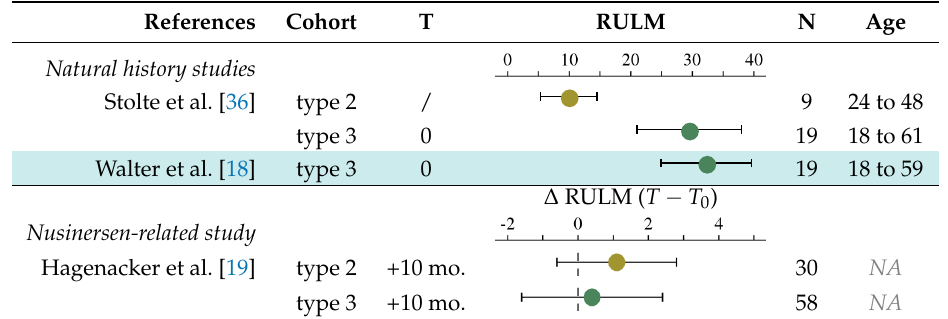
Table 3. Summary of representative results for the Revised Upper Limb Module (RULM). Graphical representation of the RULM scores in SMA patients from three independent studies. Columns are named as follows. References : bibliographic citations of the natural history or